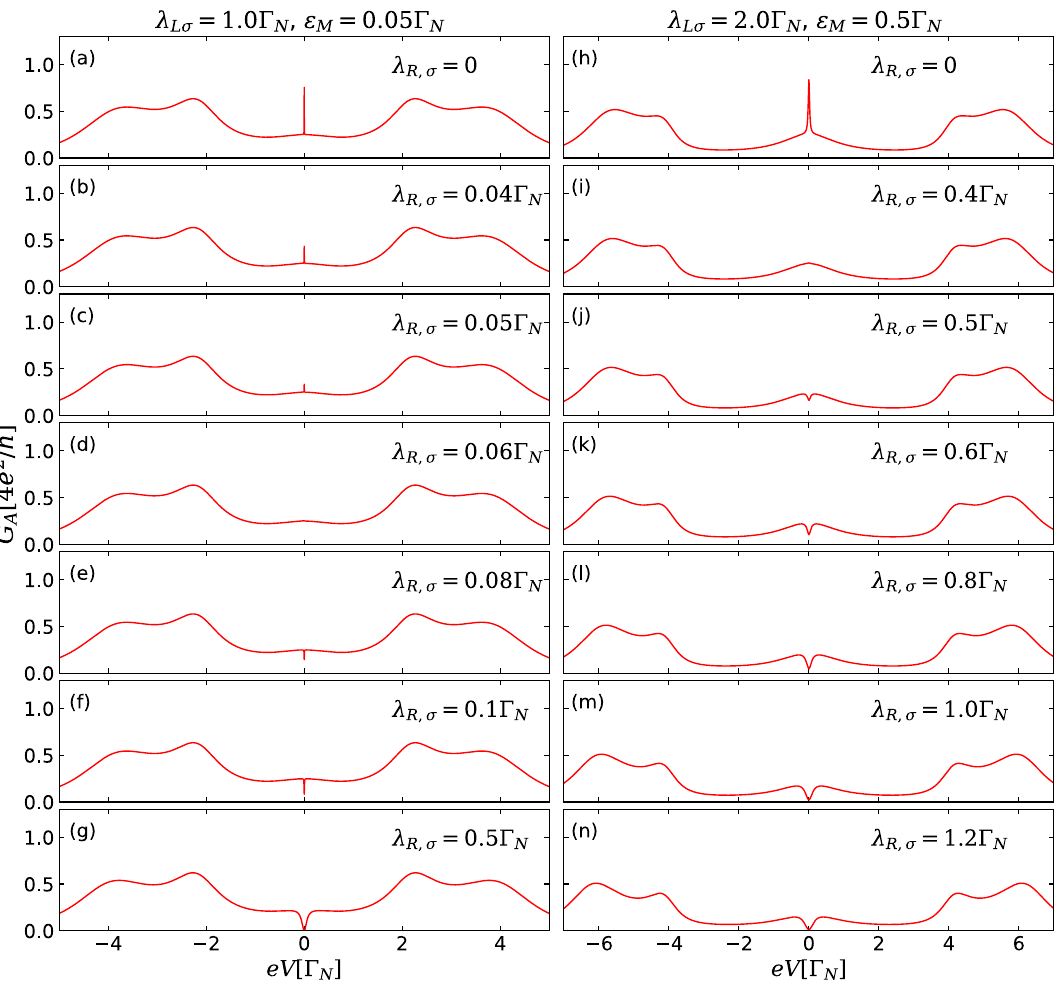
Figure 8. Andreev conductance G A [Eq. (5)] as a function of the bias-voltage for spin symmetric case 0.05 Ŵ 0.5 ) and distinct values of (cid:31) ( p R σ . In left panels ( a – g ), ε M = N and the other parameters are the same = (cid:31) 3.0 Ŵ 1.2 Ŵ 1.0 Ŵ 1.0 Ŵ adopted in Fig. 7: (cid:31) L N and V Z = N . In right panels [(h)-(n)], N , Ŵ S = L N , eV g = − ↑ = ↓ = (cid:31) (cid:31) 0.5 Ŵ 4.0 Ŵ 2.0 Ŵ 1.5 Ŵ 2.0 Ŵ ε M N and we adopt N and V Z = N . In both the set N , Ŵ S = L L N , eV g = − = ↑ = ↓ = 2 eV g of parameters chosen the Anderson symmetric condition U is = | |